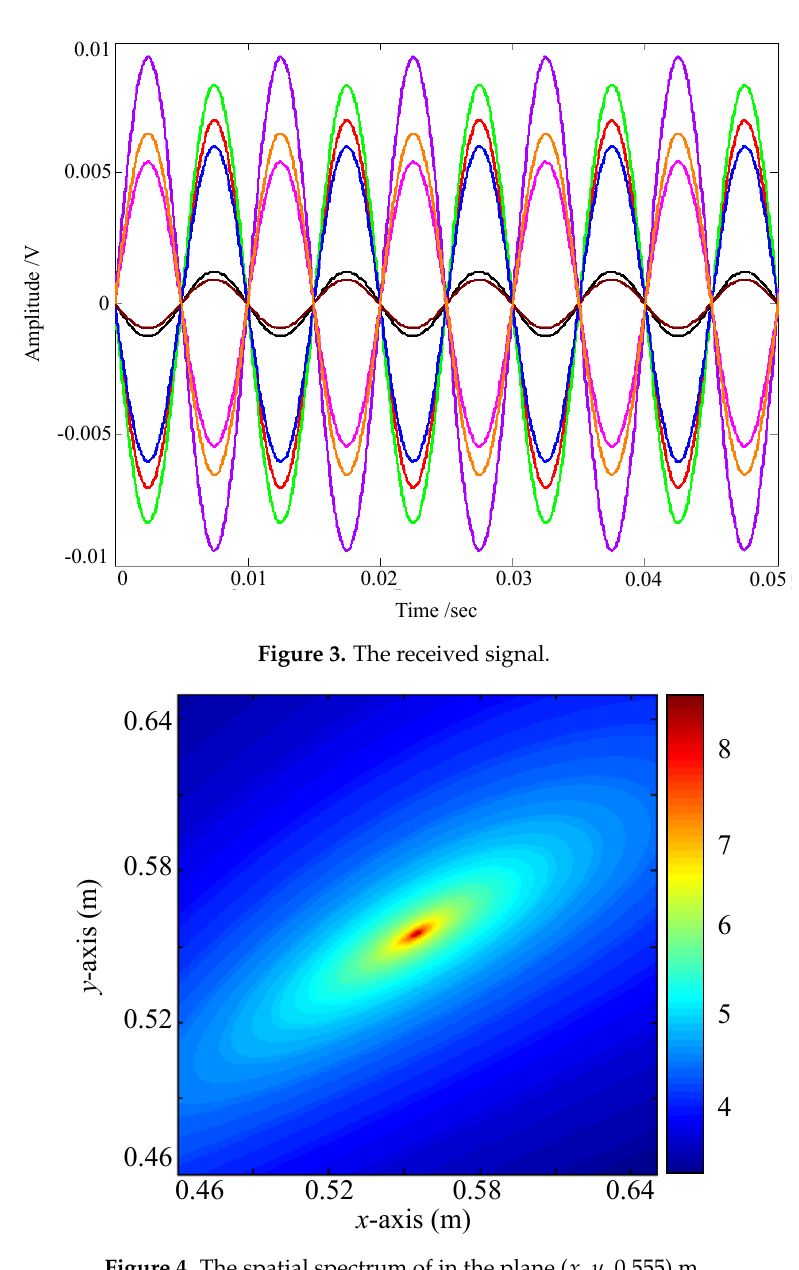
Figure 4. The spatial spectrum of in the plane ( x , y , 0.555)